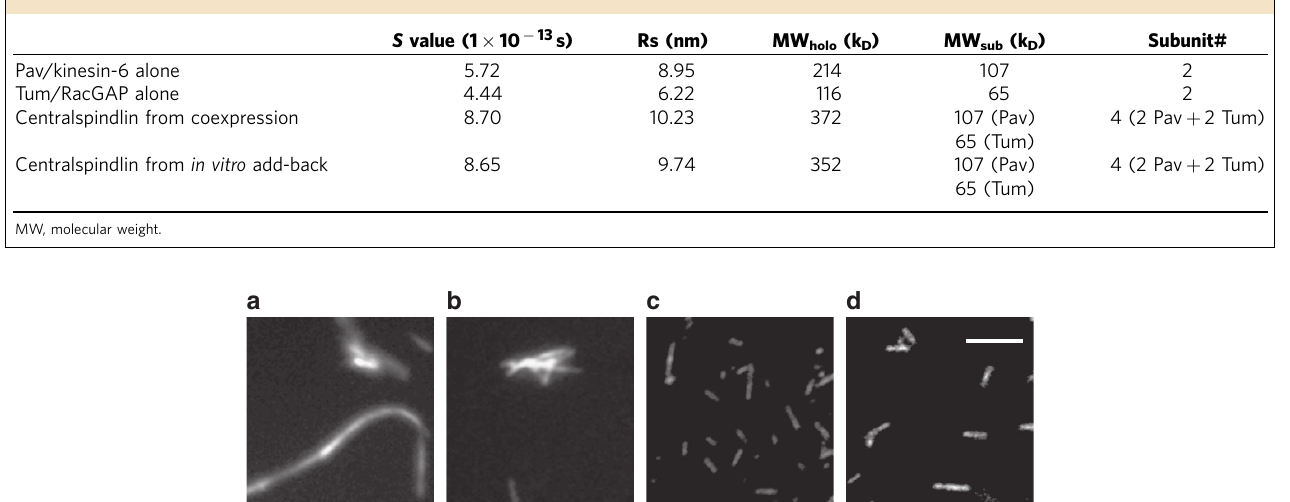
Figure 1 | Purification of centralspindlin components from the baculovirus expression system. ( a ) Commassie blue-stained SDS–polyacrylamide gel (8%) shows eluates of full-length centralspindlin, Pav/kinesin-6, Tum/RacGAP and a negative control (protein purified from sf9 cells infected with no-gene-bearing baculoviruses) obtained from Ni-NTA affinity column. ( b ) Commassie blue-stained SDS–polyacrylamide gel (20%) shows fragment Tum1–65 eluate obtained from Ni-NTA affinity column. ( c ) Commassie blue-stained SDS–polyacrylamide gel shows the composition of protein fractions obtained during the purification of centralspindlin from the gel-filtration chromatography (Superose 6 FPLC, GE Pharmacia). ( d ) Corresponding plot of protein concentration versus fraction number demonstrates the centralspindlin complex elutes in a single peak. Table 1 | Hydrodynamic properties of various centralspindlin components.